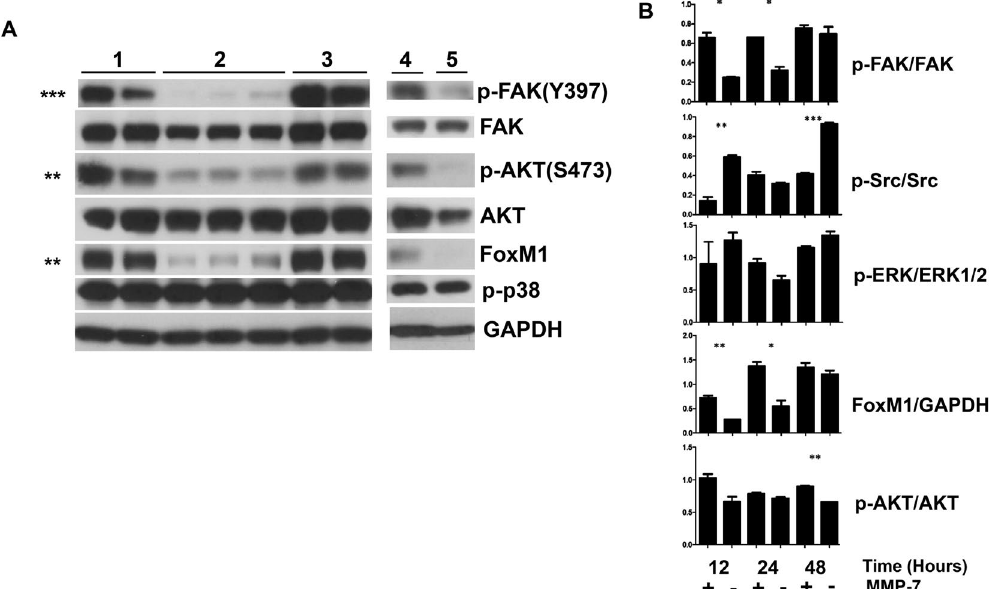
Figure 4. Full length perlecan and Domain IV-3 strongly dephosphorylate focal adhesion kinase (FAK) and alter several downstream signaling components. ( A ) C4-2 cells were cultured on several substrates (Set 1: Control BSA/digest buffer, set 2: Domain IV-3 alone, set 3: Domain IV-3 + MMP-7, set 4: perlecan + MMP- 7, and set 5: perlecan alone) for 24 hours and probed for phosphorylated FAK (p-FAK), total FAK, p-AKT, FoxM1, p-p38, and GAPDH. Unpaired student t-tests between sets 2 and 3 were performed for densitometry quantified values of p-FAK/FAK, p-AKT/AKT, FoxM1/GAPDH, and p-p38/GAPDH. ( B ) A 12, 24 and 48- hour time course of C4-2 cells cultured on Domain IV-3 incubated either alone ( − ) or with MMP-7 ( + ) and probed for signaling components that were quantified by densitometry. An unpaired student’s t-test measured any significant difference between cells on Domain IV-3 or Domain IV-3 pre-cleaved with MMP-7 at each time point. p-values: * < 0.05, ** < 0.01, *** < 0.001. Expanded view of blots included in composite figure included in supplemental data